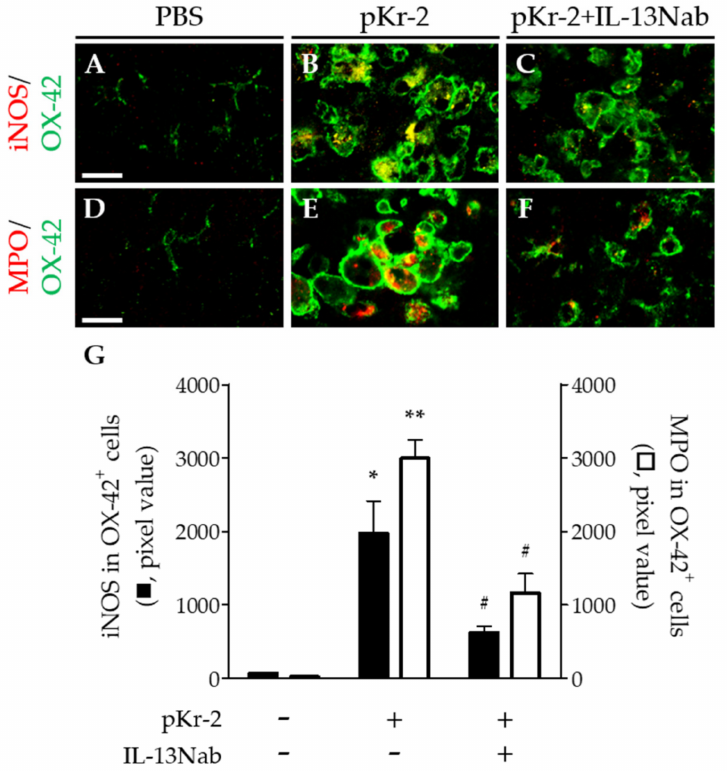
Figure 4. IL-13 is involved in expression of microglia/macrophages and neutrophils -derived myeloperoxidase (MPO) and inducible nitric oxide synthase (iNOS) in the CA1 layer of pKr-2- injected hippocampus in vivo. PBS ( A , D ) or pKr-2 ( B , C , E , F ) was unilaterally injected into the CA1 layer of hippocampus in the absence ( B , E ) or presence of IL-13Nab ( C , F ; 1 µ g). Animals were transcardially perfused and brains were prepared for immunohistochemical staining at 3 days after pKr-2 injection. ( A – C ) Double immunofluorescence images of iNOS (red) and OX-42 (green) for microglia/macrophages and neutrophils and both images are merged (yellow) in the CA1 layer of hippocampus. Scale bar, 20 µ m. ( D – F ) Double immunofluorescence images of MPO (red) and OX-42 (green) for microglia/macrophages and neutrophils and both images are merged (yellow) in the CA1 layer of hippocampus. Scale bar, 20 µ m. ( G ) Quantification of iNOS (left y axis; black rectangle) or MPO (right y axis; white rectangle) expression in OX-42 + microglia/macrophages and neutrophils. * p < 0.01, ** p < 0.001, significantly different from PBS (control). # p < 0.01, significantly different from pKr-2. Mean ± SEM; n = 4 in each group, ANOVA and Newman–Keuls